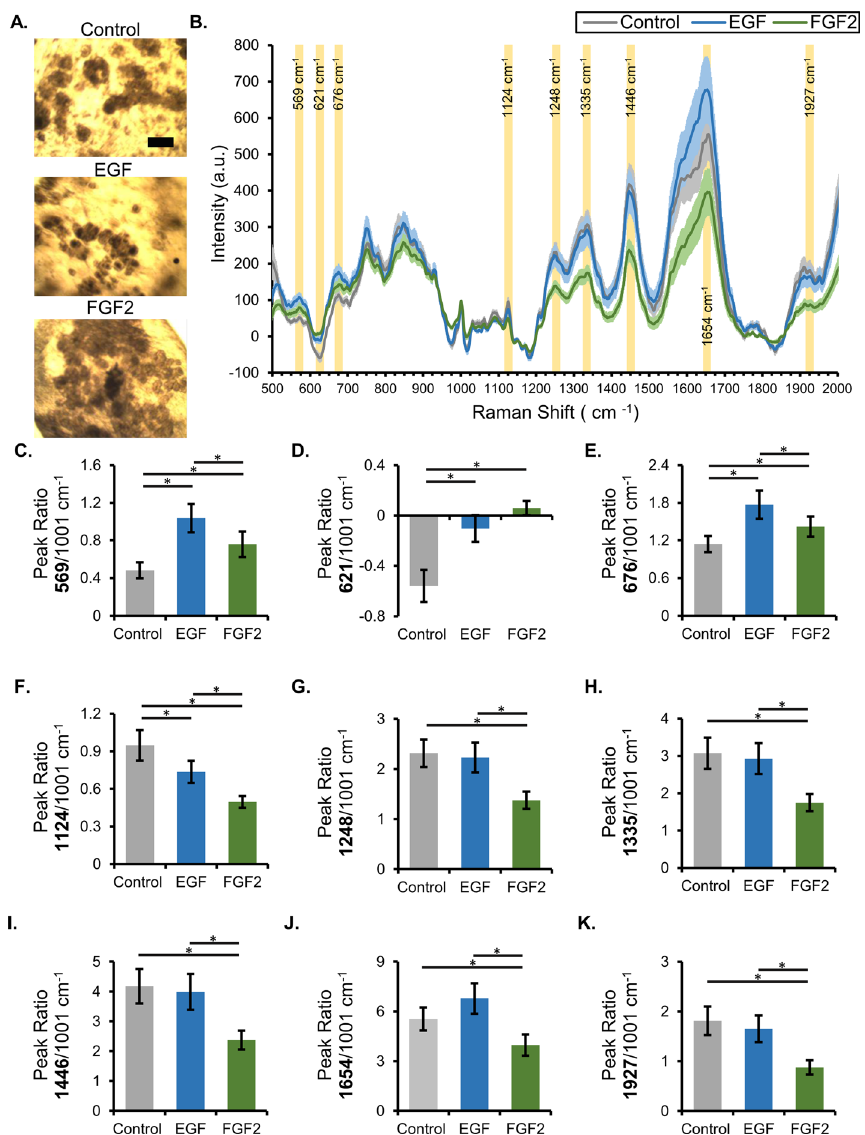
Fig. 3 FGF2-treated organoids have a Raman signature that is distinct from EGF-treated or untreated organoids. A Representative brightfield images of fixed organoids on the Raman confocal stage; the cell-dense regions (dark brown) are easily distinguished from the Matrigel-dominant area (scale bar, 200 µm). B Average Raman spectra for cell-dense regions of control and EGF- and FGF2-treated organoids, with error bars representing the 95% confidence interval. C – K Quantification of select peak intensities in the spectral dataset based on the ability to differentiate one or more treatments ( n 50 separate spectra collected from = a minimum of three independent organoids; representative experiment * asterisk indicates significance with p < 0.05; statistical summary in Additional file 1: Table